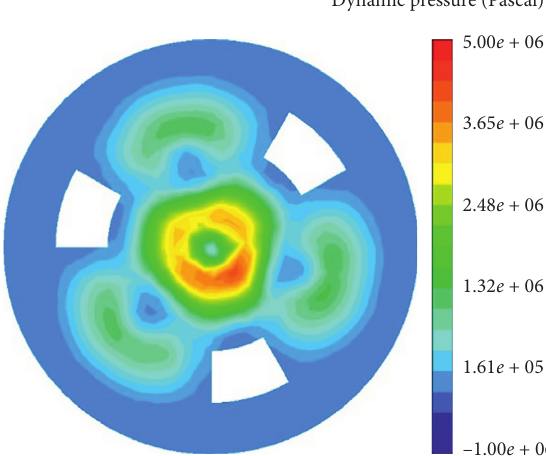
Figure 11: Bottom hole dynamic pressure distribution cloud image of the polymer additive